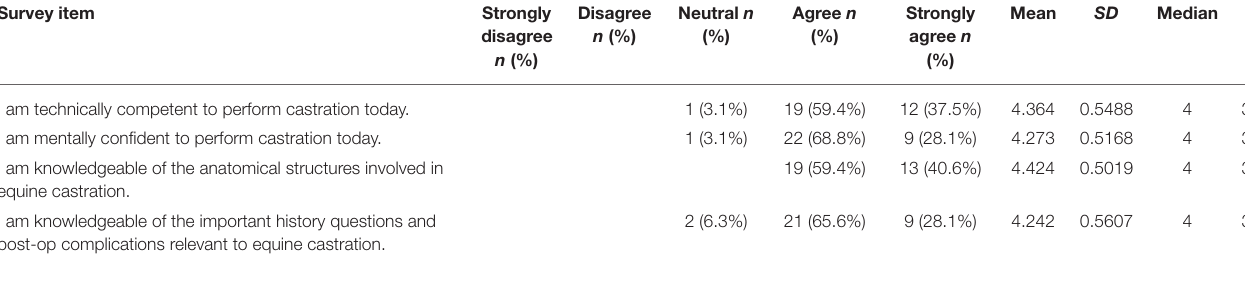
TABLE 4 | Results of student confidence survey prior to live horse castration, with model experience. Survey item